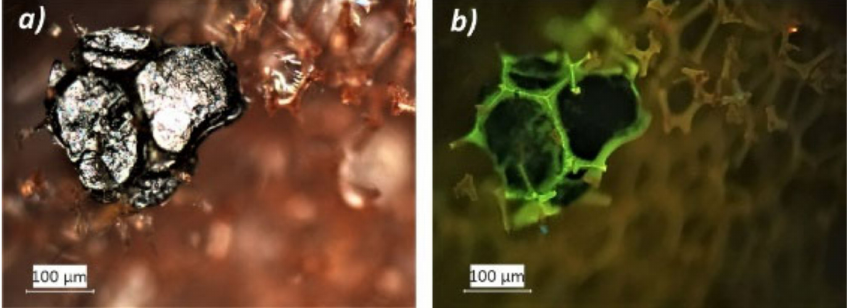
Figure 4. Photomicrographs of an unknown element detected in Austrotherm foam in reflected visible ( a ) and UV light ( b ) by optical